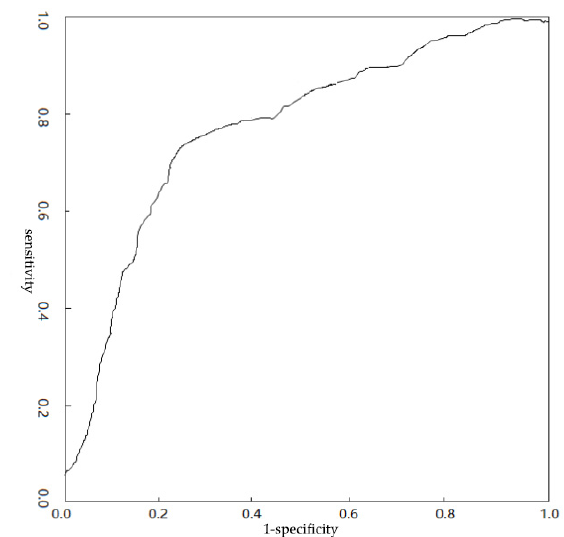
Figure 9. Decision tree disease prediction model ROC